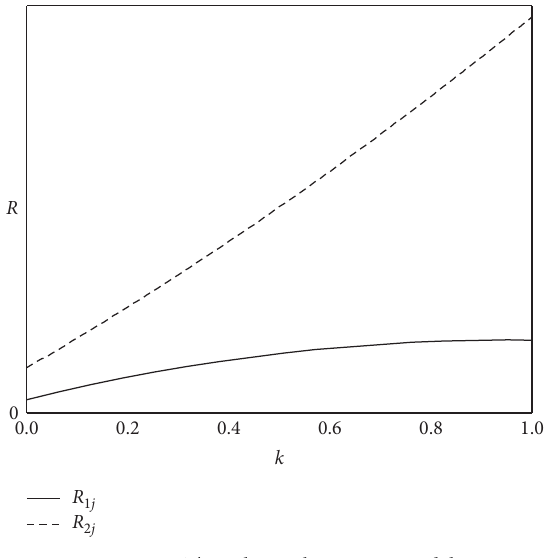
Figure 4: The relation between R and k .